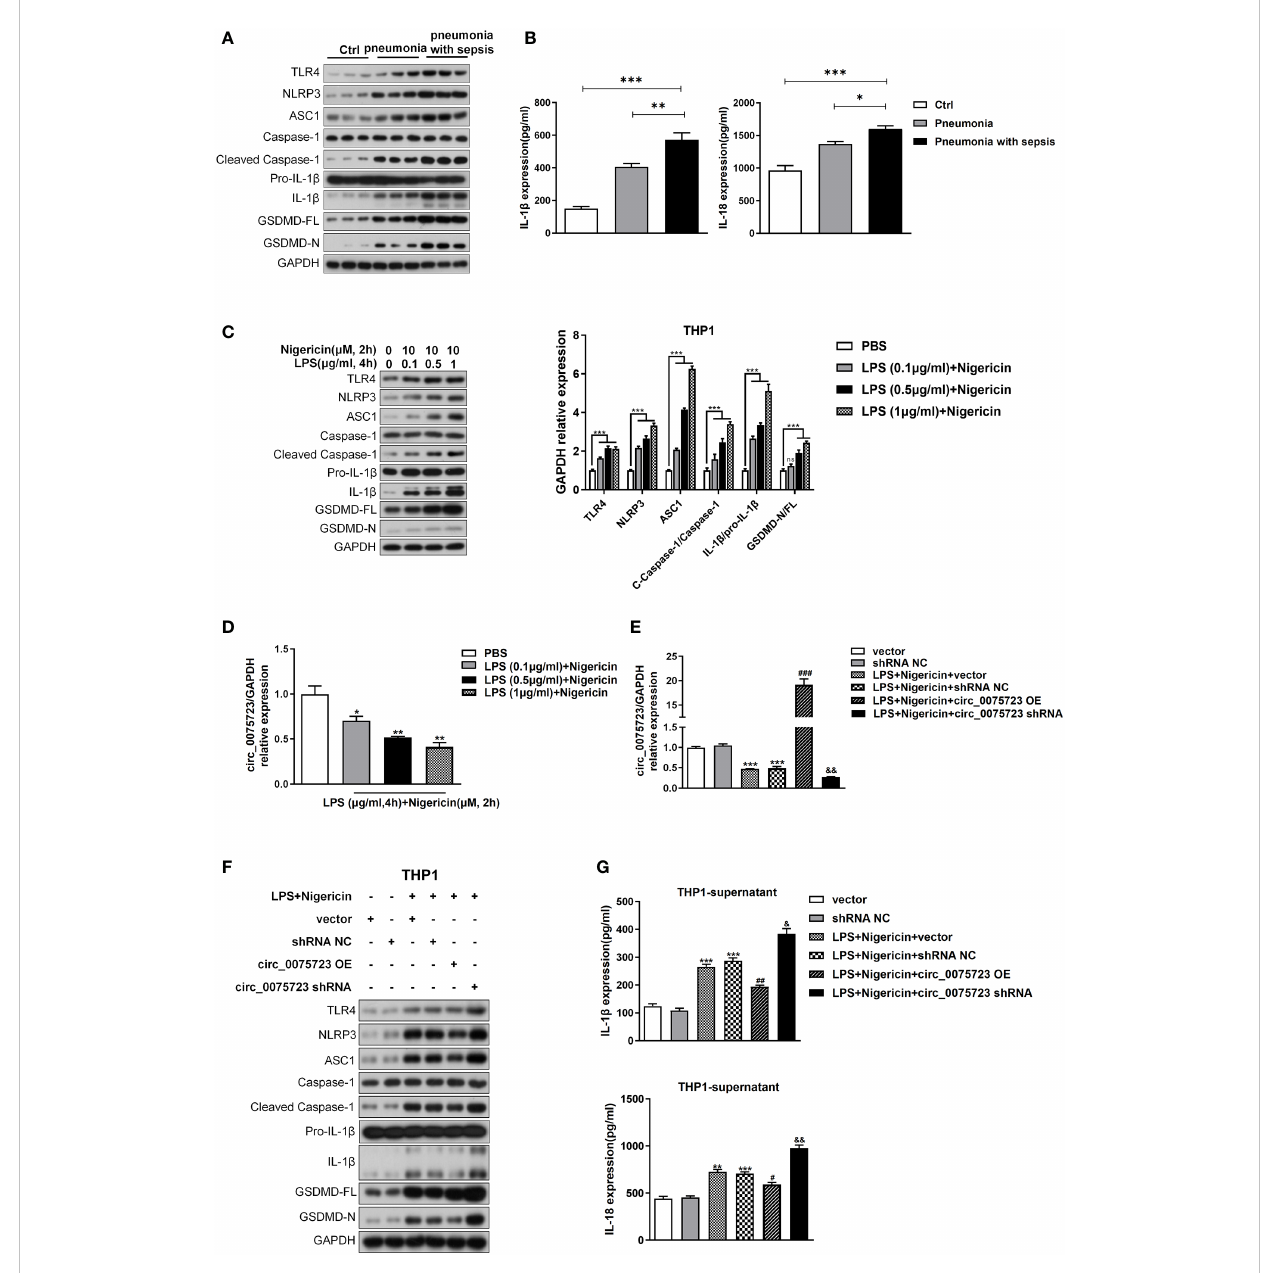
FIGURE 3 Pyroptosis is activated following pneumonia-induced sepsis and Circ_0075723 inhibits pyroptosis of THP-1 in vitro . (A) Western blot analysis of TLR4, NLRP3, ASC1, caspase1, cleaved caspase-1, Pro-IL1 b , IL-1 b , GSDMD and GAPDH in CD14+ monocytes from pneumonia-induced sepsis, pneumonia without sepsis and healthy people. (B) ELISA of IL-18 and IL-1 b in the plasma from pneumonia-induced sepsis, pneumonia without sepsis and healthy people. Each group has 4 samples. Data are presented as means ± SD; signi fi cant difference was identi fi ed with one-way ANOVA. *p < 0.05 vs. Pneumonia; **p < 0.01 vs. Pneumonia; ***p < 0.001 vs. Control. (C) Western blot analysis of TLR4, NLRP3, ASC1, caspase1, cleaved caspase-1, Pro-IL1 b , IL-1 b , GSDMD and GAPDH in THP-1 cells primed with different doses of LPS (0.1, 0.5 and 1 m g/ml) for 4 h and stimulated with nigericin (10 m M) for 2h. Data are presented as means ± SD; signi fi cant difference was identi fi ed with two-way ANOVA. ***p < 0.001 vs. PBS; ns: